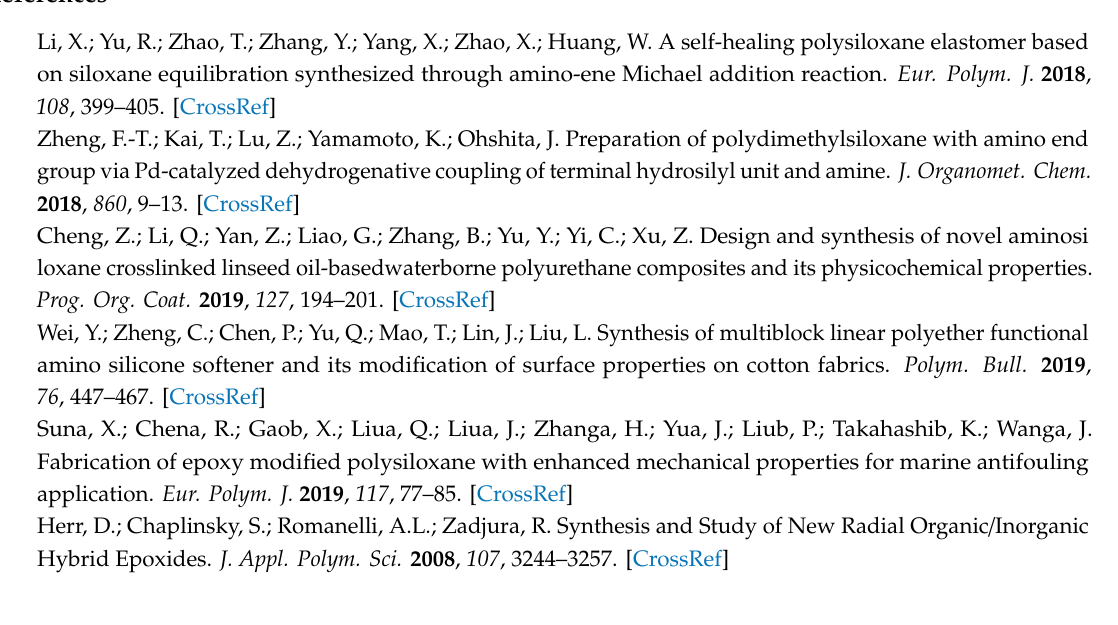
Supplementary Materials: The following are available online, Figure S1: A plot of mole fraction of the area occupied by TS-OE12 at the water-air interface ( X S ) vs. the logarithm of its concentration (log C S ) at a temperature equal to 293 K, 303 K and 313 K determined from Equation (4), Figure S2: A plot of mole fraction of the area occupied by TS-OE12 at the water-air interface ( X S ) vs. the logarithm of its concentration (log C S ) at a temperature equal to 293 K, 303 K and 313 K determined from Equation (6), Figure S3: A plot of logarithm of mole fraction of the area occupied by TS-OE12 at the water-air interface (log X S ) vs. the logarithm of its concentration (log C S ) at a temperature equal to 293 K, 303 K and 313 K determined from Equation (6), Figure S4: Values of surface tension ( γ LV ) of aqueous solutions of TS-OE12 (curves 1–3) determined from Equation (7) at 298 K, 303 K and 313 K vs. the logarithm of surfactant concentration (log C S ). Figure S5: A plot of the pyrene ( I 1 / I 3 ) and ( I 3 / I 1 ) ratios vs. the logarithm of TS-OE12 concentration (log C S ) at 303 K, Figure S6: A plot of the pyrene ( I 1 / I 3 ) and ( I 3 / I 1 ) ratios vs. the logarithm of TS-OE12 concentration (log C S ) at 313